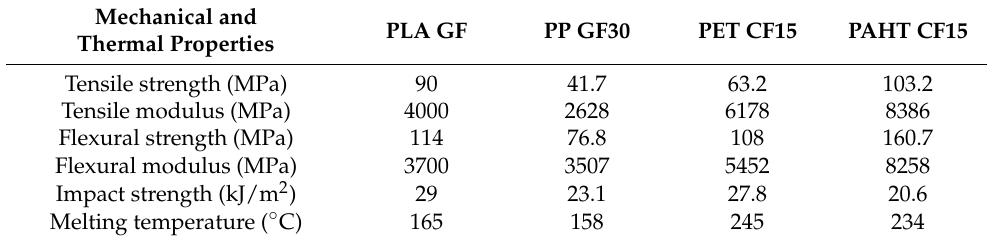
Table 2. Mechanical and thermal properties of filaments [31–34].